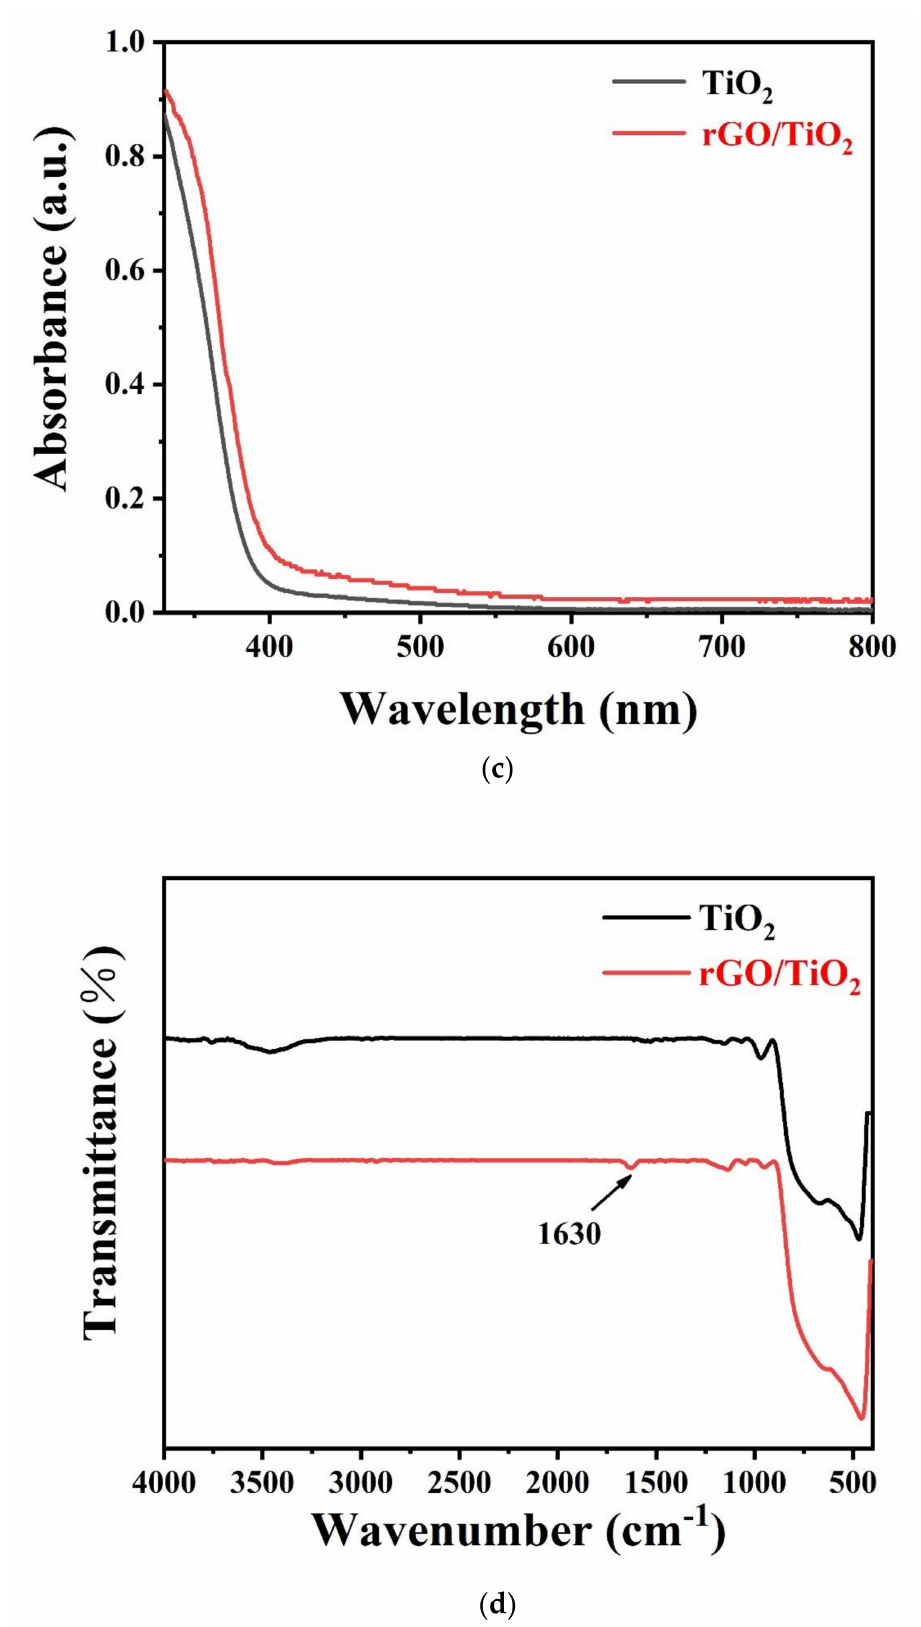
Figure 1. Schematic representation of the formation of ( a ) rGO/TiO2 heterojunction assembly pho- tocatalysts; ( b ) X-ray diffraction (XRD) patterns, ( c ) UV–visible diffuse reflectance spectra, and ( d ) FTIR of TiO 2 and rGO/TiO 2 ,